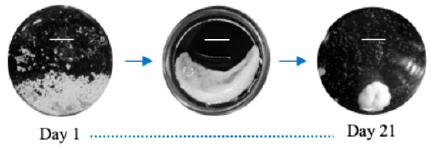
Figure A2. MT contraction process. Scale bars = 2 mm.